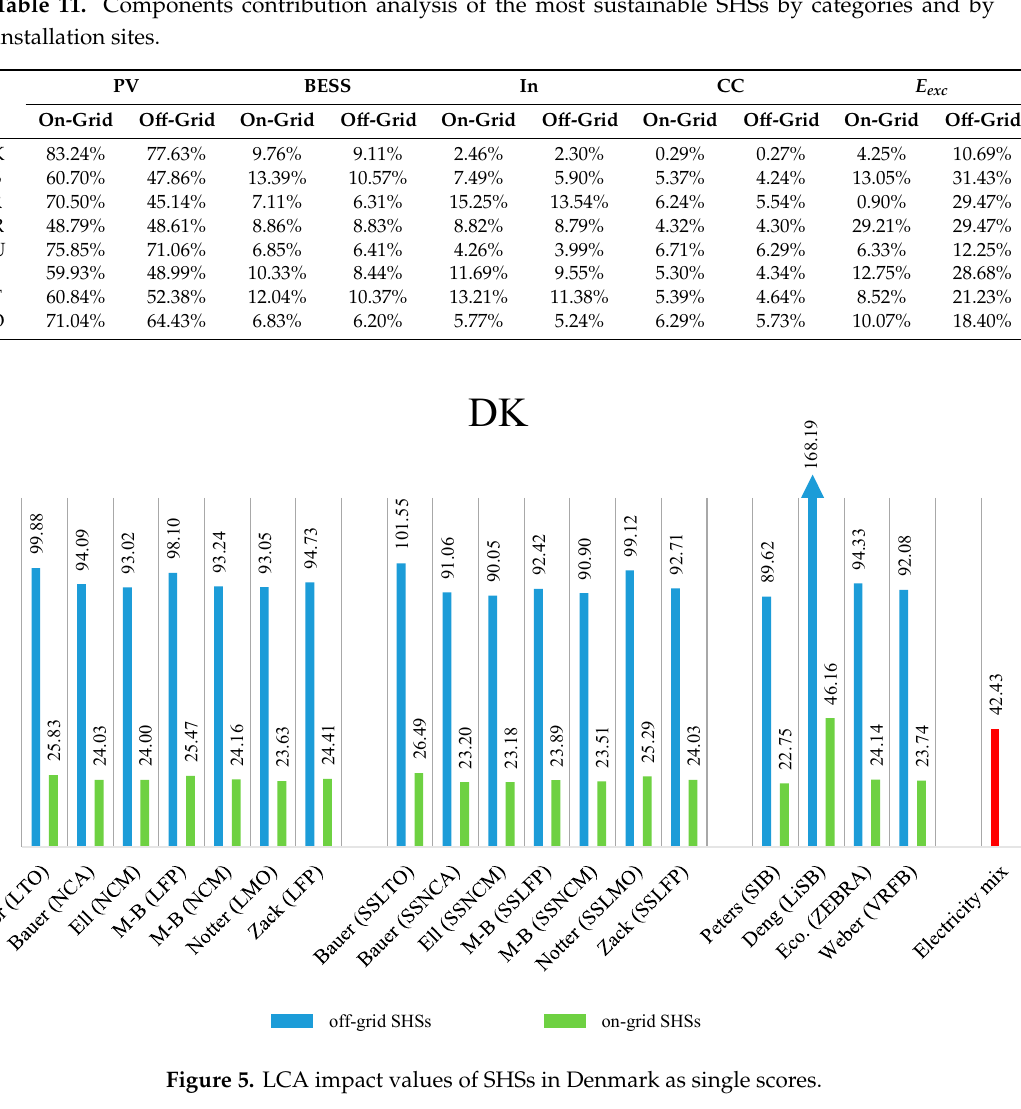
Figure 6. LCA impact values of SHSs in Spain as single scores.